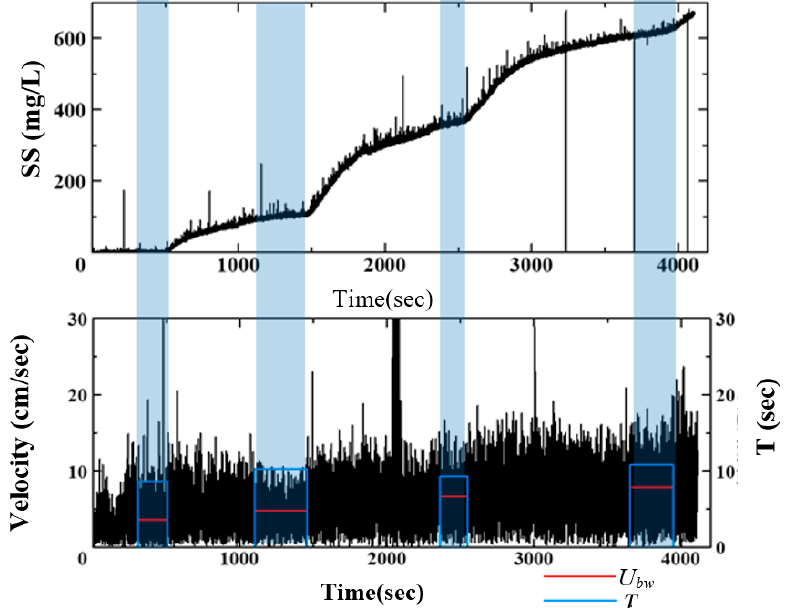
Figure 17. Example of results of the laboratory experiments. T as the blue bars were obtained from the fluctuation of the velocity with Fourier analysis.